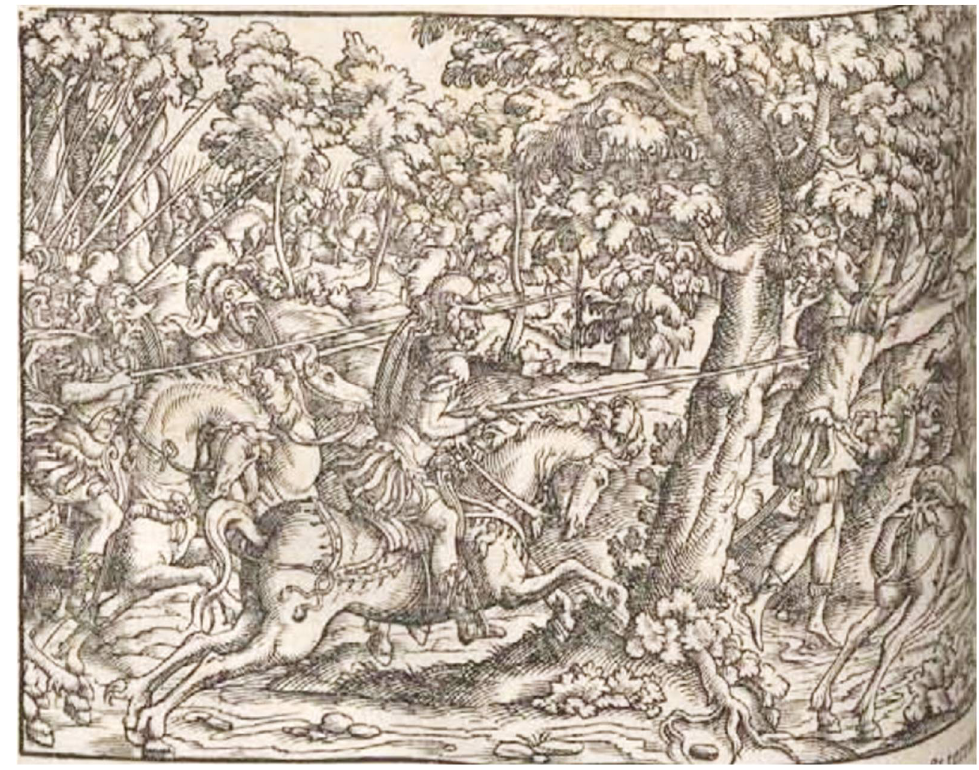
Figure 37. The inspiration for the figural decorations of the manor house in Zagrodno was provided by Biblia Ad Vetustissima. Source: Biblia Ad Vetustissima (1566, fol. 35).